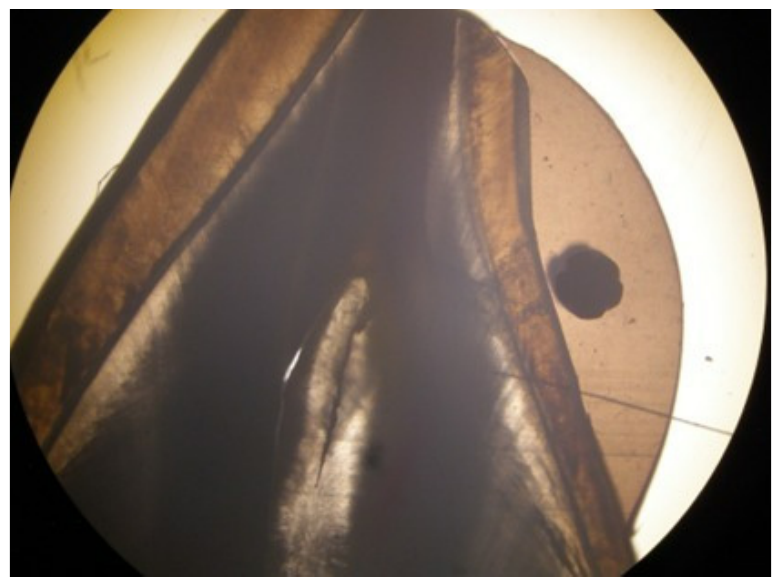
Figure 5. Stereomicroscopy at a magnification of 4 times of a 1 mm section of a composite specimen displaying the retainer-incorporating composite on the enamel surface.